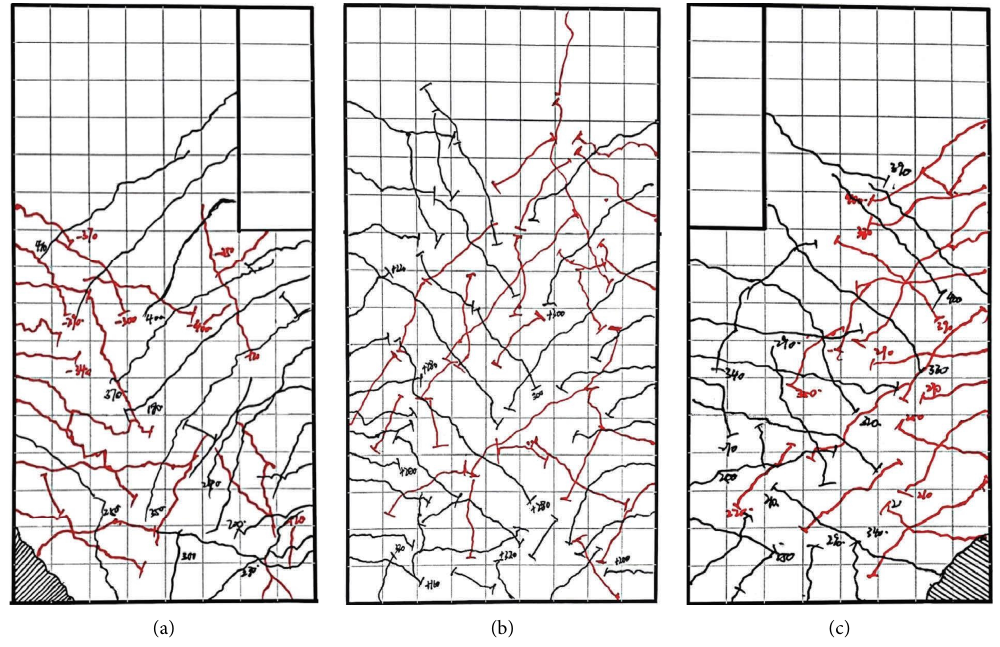
Figure 15: Damage results of URC-Y specimen. (a) Wall limb 1. (b) Web. (c) Wall limb